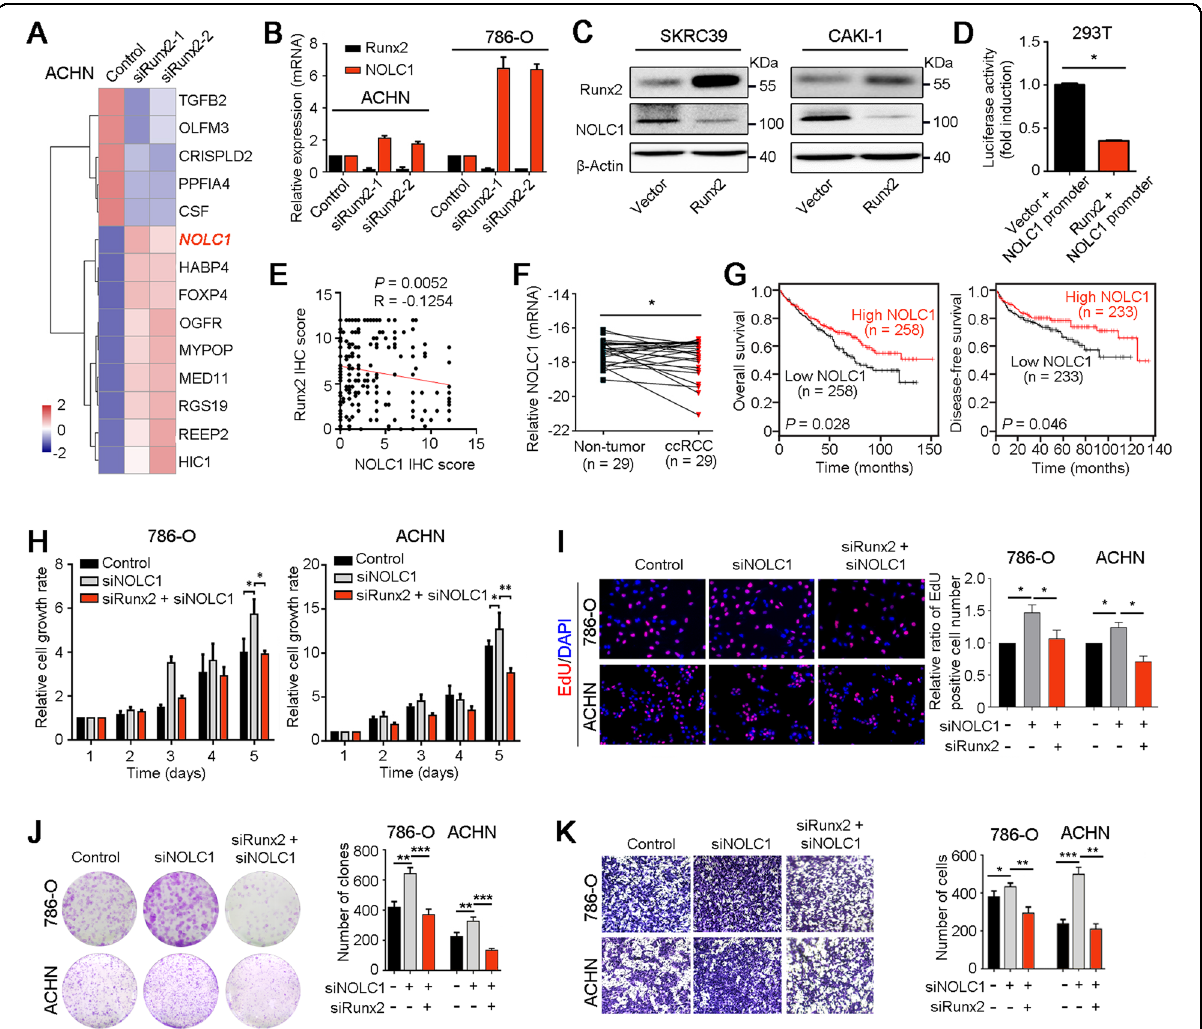
Fig. 4 NOLC1 mediates the regulation of Runx2 in ccRCC cell growth and metastasis. A RNA-sequencing was performed on ACHN cells transfected with two siRNA targeting Runx2, and the genes with signi fi cant changes were indicated by heat map. B The mRNA expressions of Runx2 and NOLC1 in ACHN and 786-O cells after knockdown of Runx2 were analyzed by qRT-PCR. C Western blot analysis showed the downregulation of NOLC1 in SKRC39 and CAKI-1 cells after overexpression of Runx2. β -Actin was also tested as a loading control. D Luciferase report assay showed that high expression of Runx2 inhibited the transcription of NOLC1. E IHC staining analysis in ccRCC tissue array showed the negative correlation between the expressions of Runx2 and NOLC1. F qRT-PCR was used to analyze the expression level of NOLC1 in ccRCC and corresponding normal renal tissues at mRNA level. G Survival analyses of ccRCC patients with different expression level of NOLC1 based on TCGA datasheet. H – J MTT test ( H ), EdU incorporation ( I ), and foci formation ( J ) assays were performed to analyze the proliferation of 786-O and ACHN cells after knockdown of NOLC1 or/ and Runx2, respectively. K The migration ability of ccRCC cells after interference of NOLC1 or/and Runx2 was analyzed by Transwell migration assay. In all panels, *, P < 0.05; **, P < 0.01; ***, P <